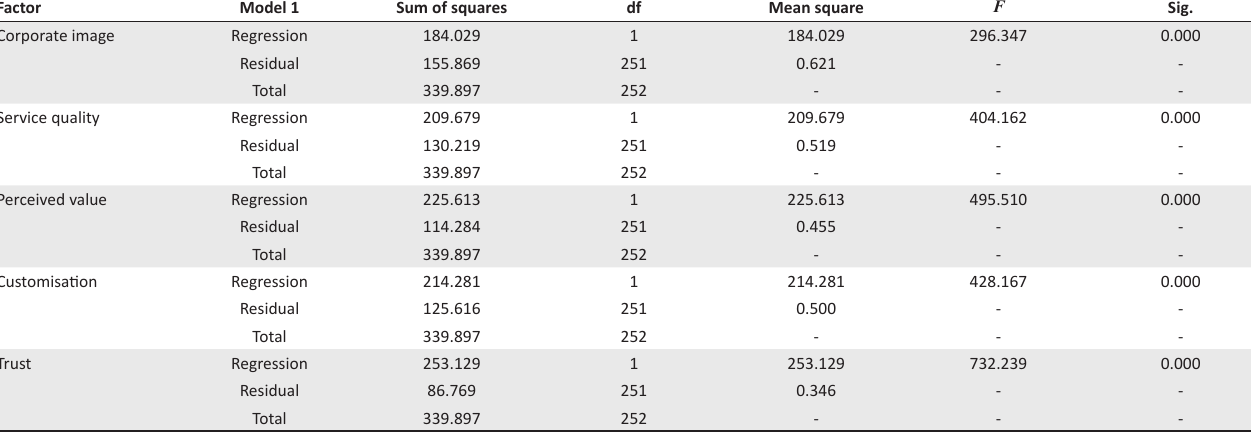
TABLE 4b: Influence of the independent variables on the intervening variable. ANOVA.